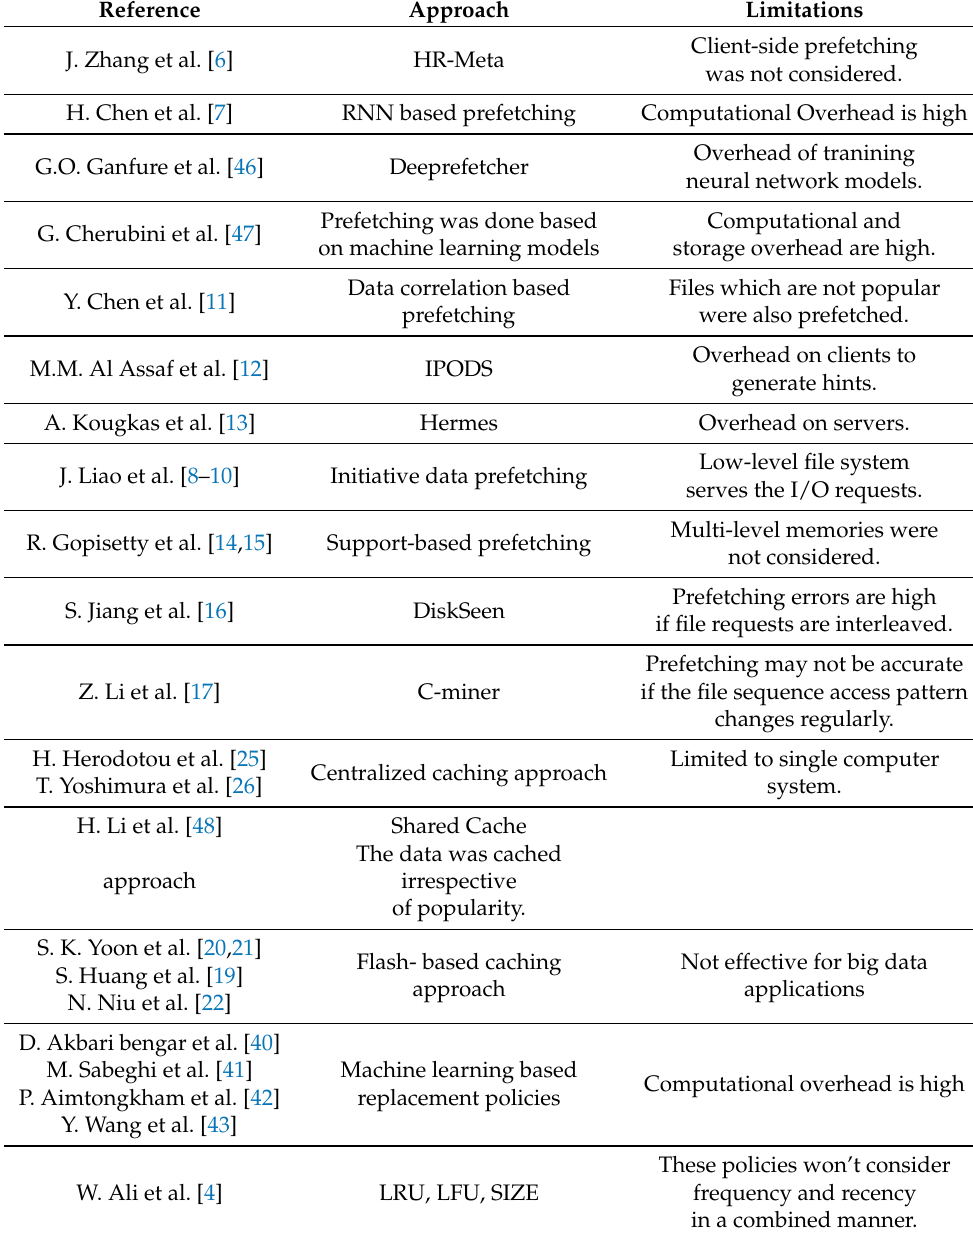
Table 1. Related